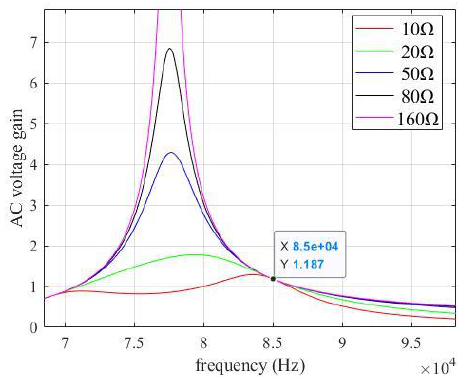
Figure 10. Voltage gain with respect to frequency for different load conditions.